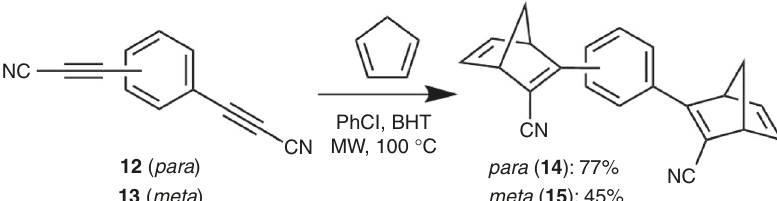
Fig. 4 Synthesis of phenylene-linked dimers. Synthesis of phenylene-linked norbornadiene dimers 14 and 15 . BHT “ butylated hydroxytoluene ” , i.e., 2,6-di (tert-butyl)-4-methylphenol; MW microwave